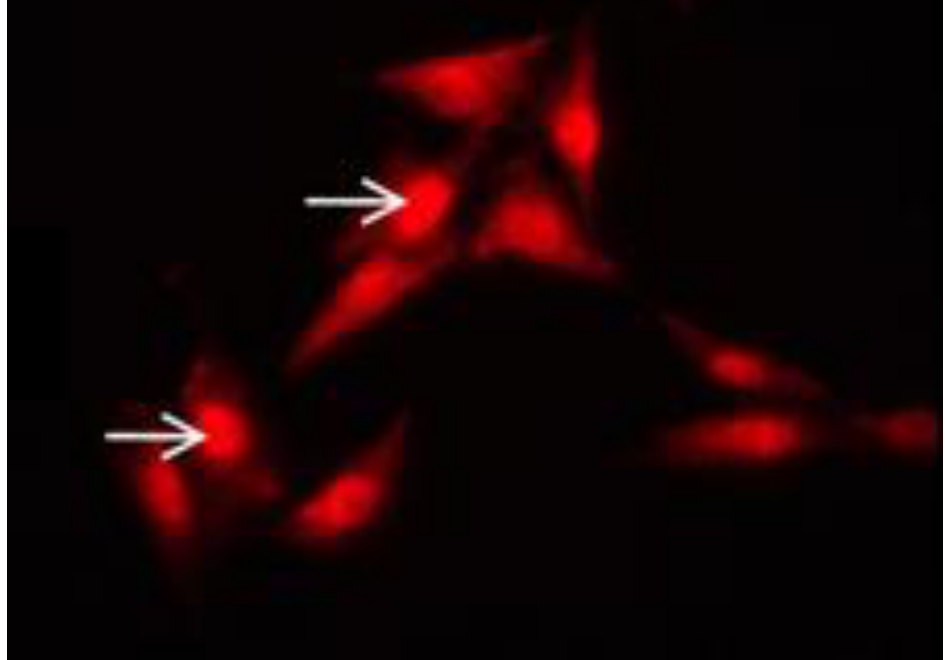
Figure 2. Intracellular nuclear localization of hBD-1 (arrows) in MG63 cells using fluorescence